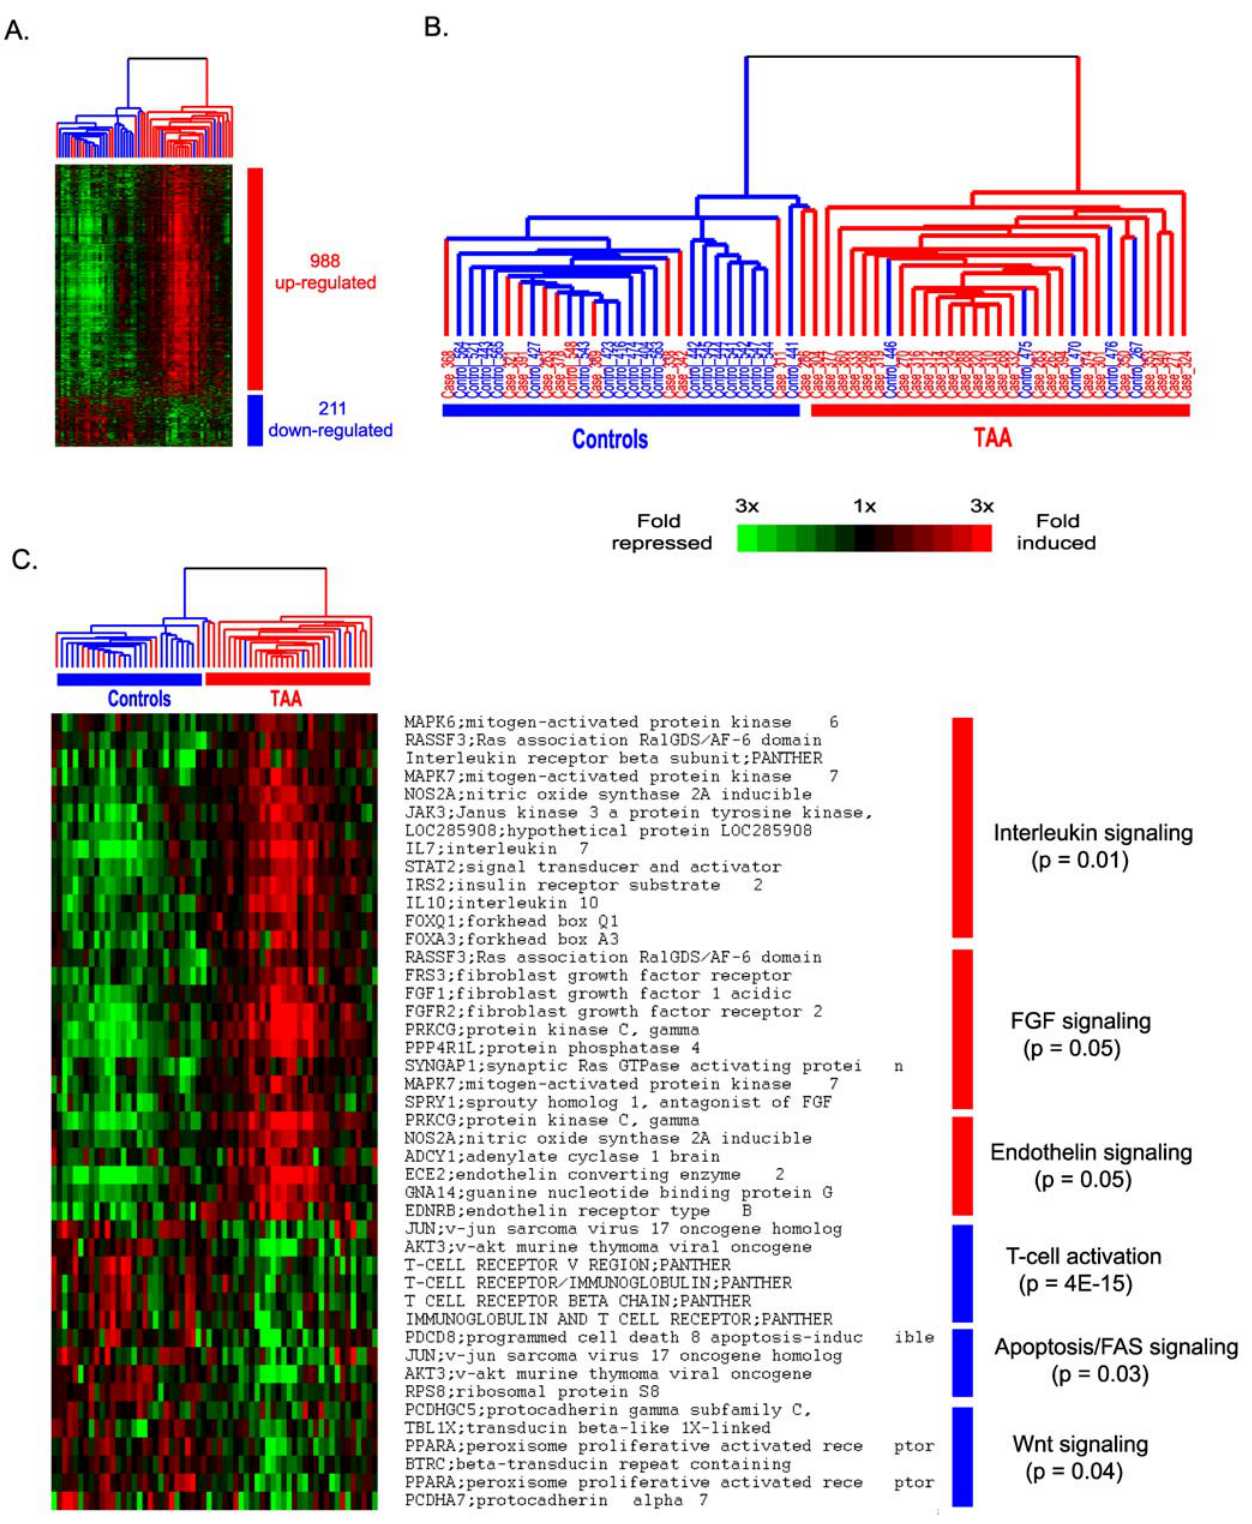
Figure 1. Hierarchical clustering of 61 whole blood samples analyzed by Applied Biosystem Expression Arrays using the 1199 differentially expressed genes determined by SAM analysis. The level of expression of each gene in each sample, relative to the mean level of expression of that gene across all the samples, is represented using a red-black-green color scale as shown in the key (green: below mean; black: equal to mean; red: above mean). (A). Scaled down representation of the entire cluster of the 1199 signature genes and 61 whole blood samples. (B). Experimental dendrogram displaying the clustering of the samples into two main branches: the TAA branch (red) and the control branch (blue) with a few exceptions. (C). Gene expression pattern of representative genes within biological pathways that are statistically significantly over-represented (random overlapping p -value , 0.05) by the up-regulated (red bars) or the down-regulated (blue bars) signature genes of TAA.